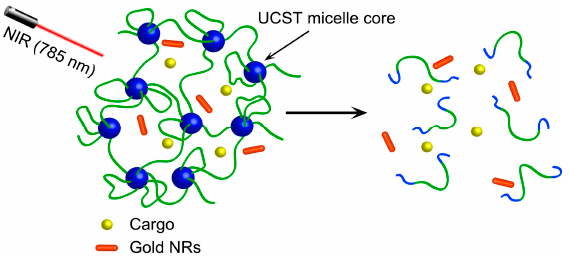
Figure 3. Schematic Illustration of NIR-light-triggered UCST gel–sol process due to heating by encapsulated AuNRs.